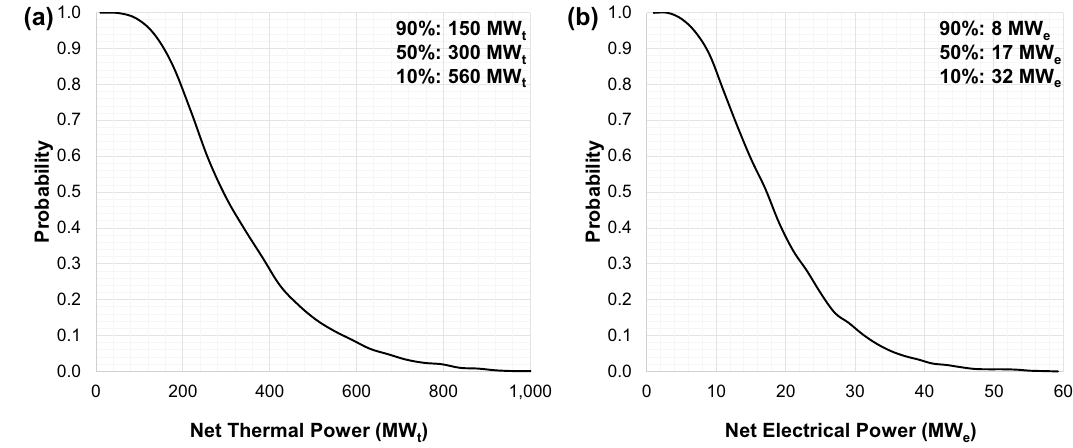
Fig. 8 Cumulative expectation curve for Kozak-EGS reservoir for real-volume case a direct utilization, b indirect utilization